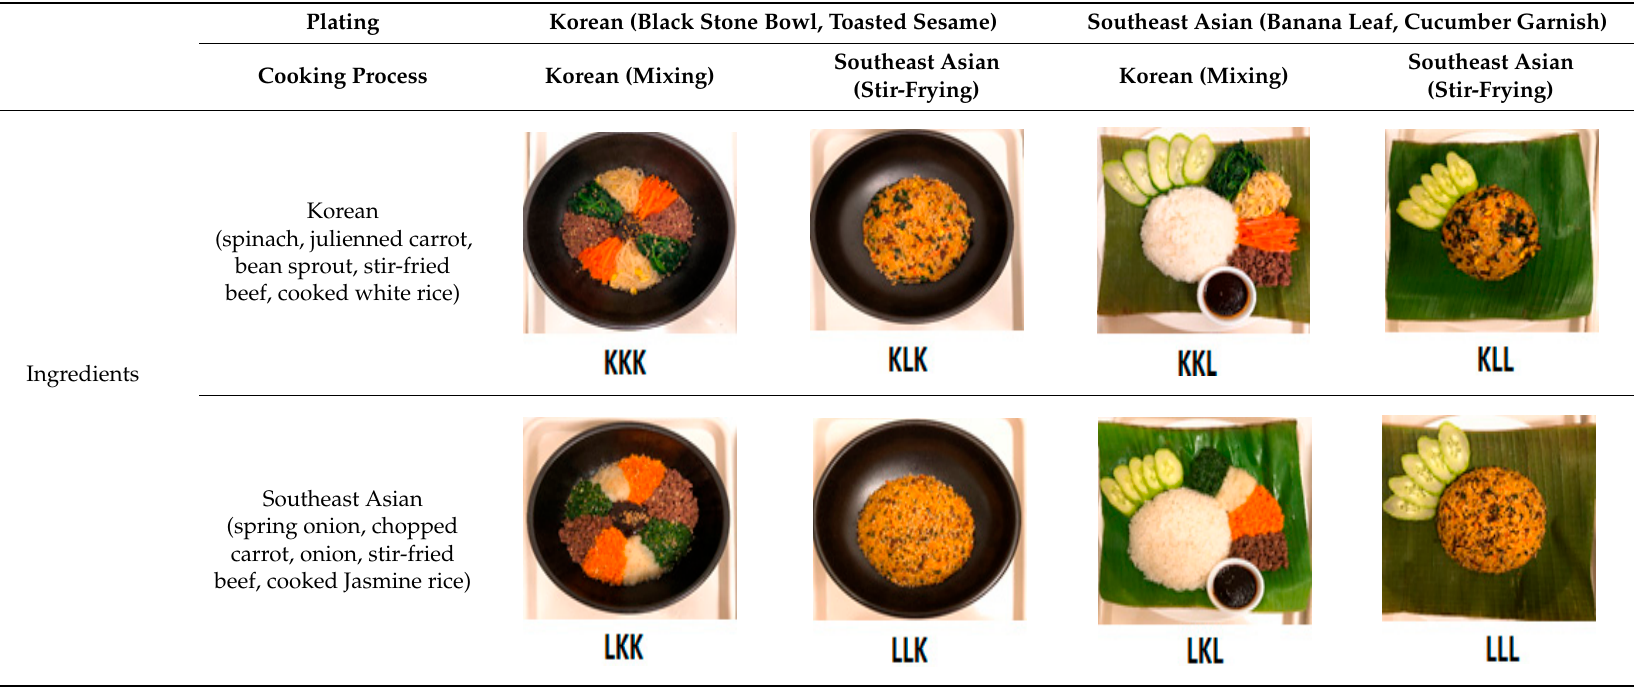
Table 1. Eight formulations of rice dish samples prepared with a 2 3 factorial combination of plating, cooking process, and ingredient in Korean or Southeast Asian styles.